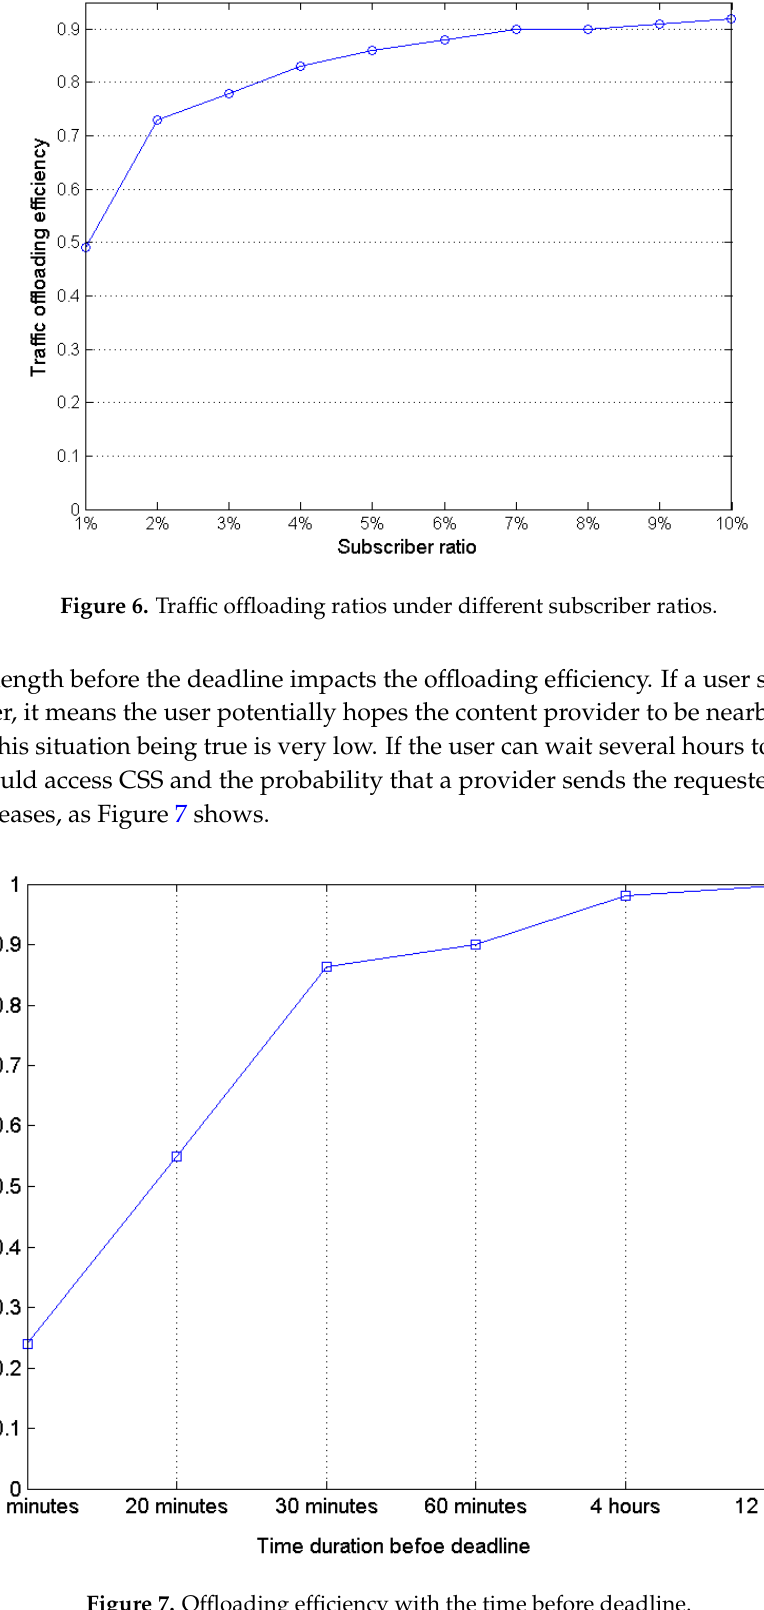
Figure 7. Offloading efficiency with the time before deadline.